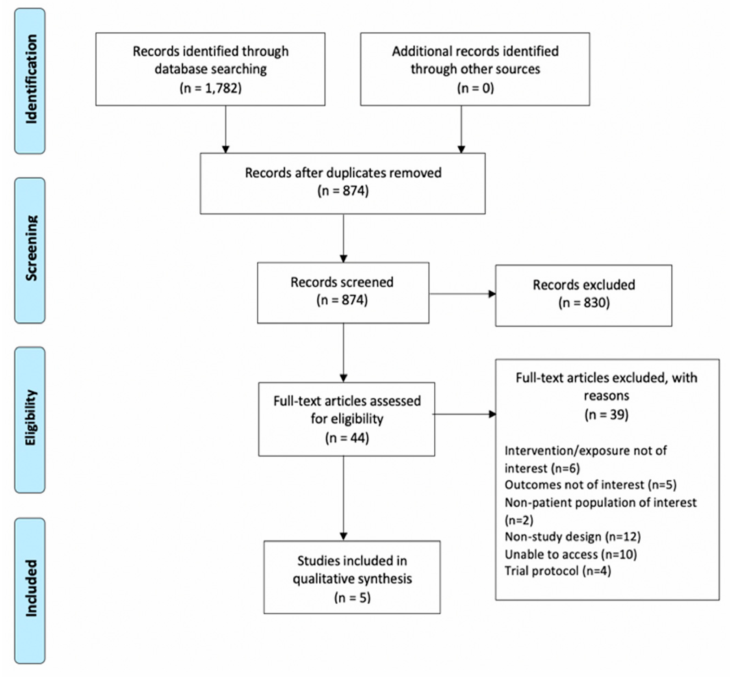
Figure 1. PRISMA flow chart of the study selection